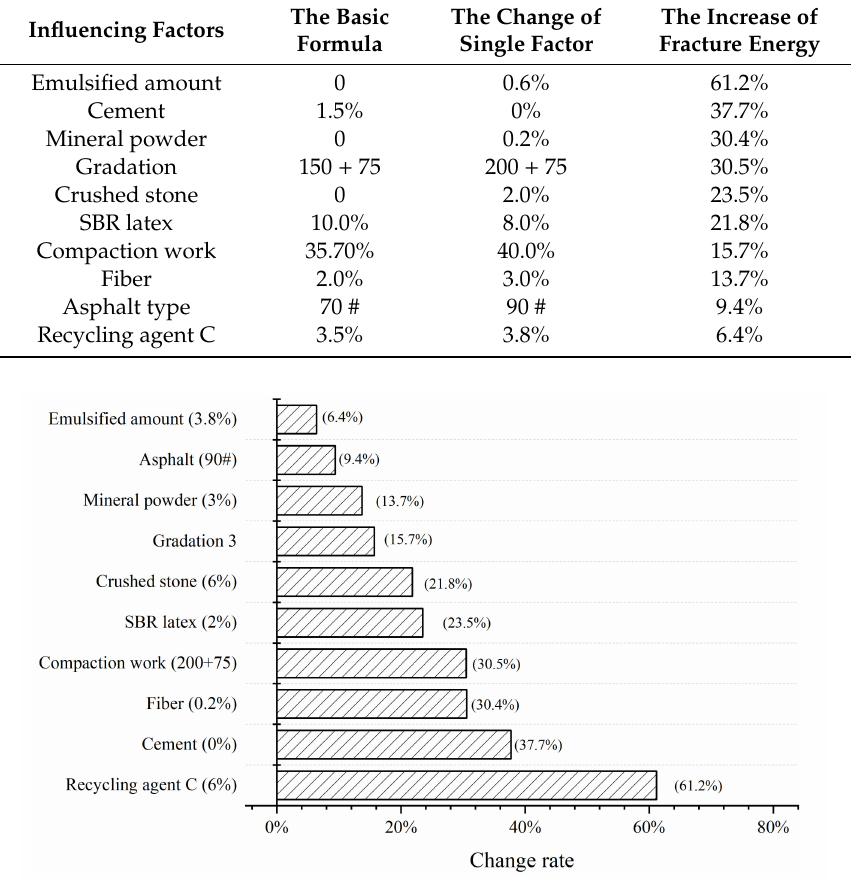
Table 5. Influence of single factor change on fracture energy.